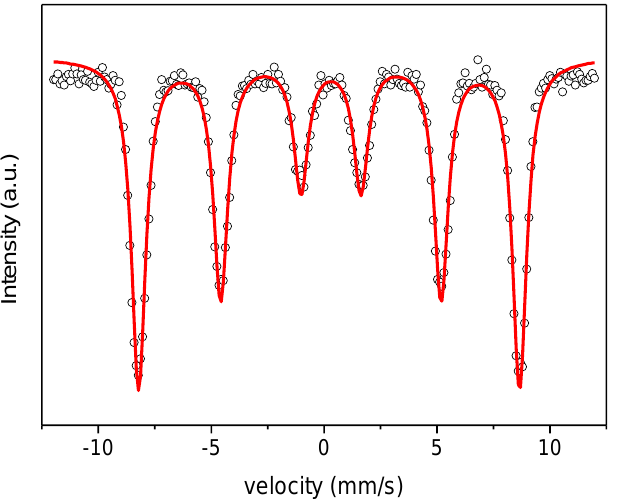
Figure 7. Experimental room temperature Mössbauer spectrum (symbols) and model fitting (lines) of the resulting LaFeO 3 pellet obtained after the reaction flash sintering process.